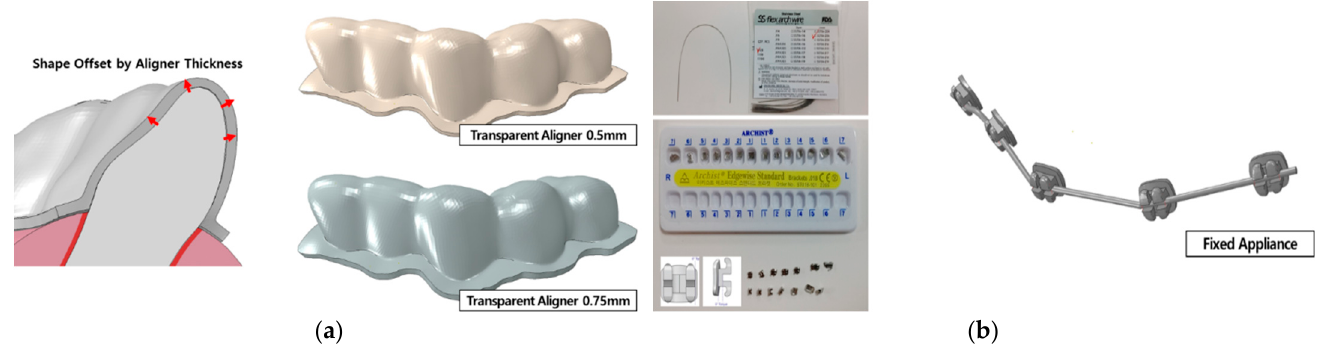
Figure 3. Orthodontic appliance finite element models. ( a ) Model developed by offsetting the outer shape of the crown and gingiva with 0.5-mm and 0.75-mm-thick transparent aligners; ( b ) Model model. Six models were created: malocclusion models of inclination and axial rotation for developed through reverse engineering of previously commercialized edgewise standard bracket 0.5- and 0.75-mm-thick transparent aligners and for a fixed appliance (Figure 5). and arch-wire.